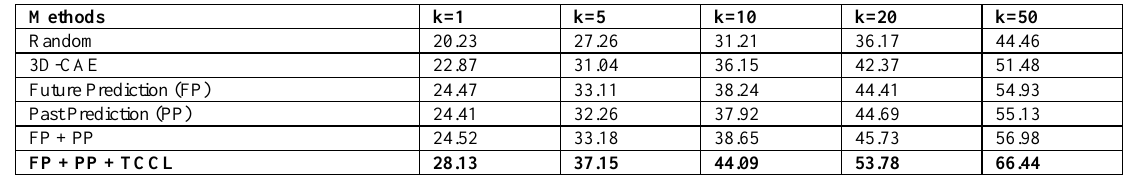
Table 4. Impact of multi-task learning on retrieval performance (Clip Level).